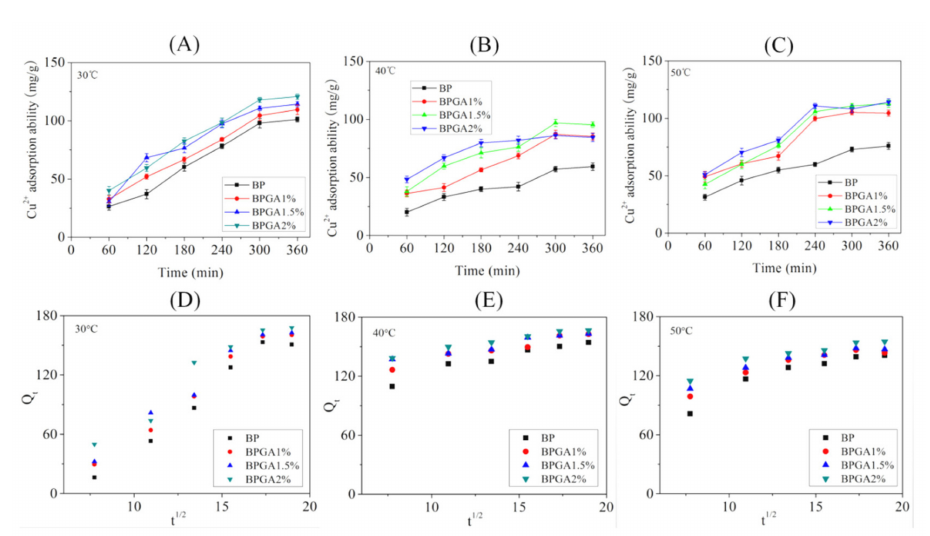
Figure 7. The adsorption kinetics of Cu 2 + onto the prepared adsorbent materials at 30 ◦ C ( A ), 40 °C ( B ) and 50 ◦ C, ( C ) intraparticle di ff usion models for the adsorption of Cu 2 + at 30 ◦ C ( D ), 40 ◦ C ( E ), and 50 ◦ C ( F ).